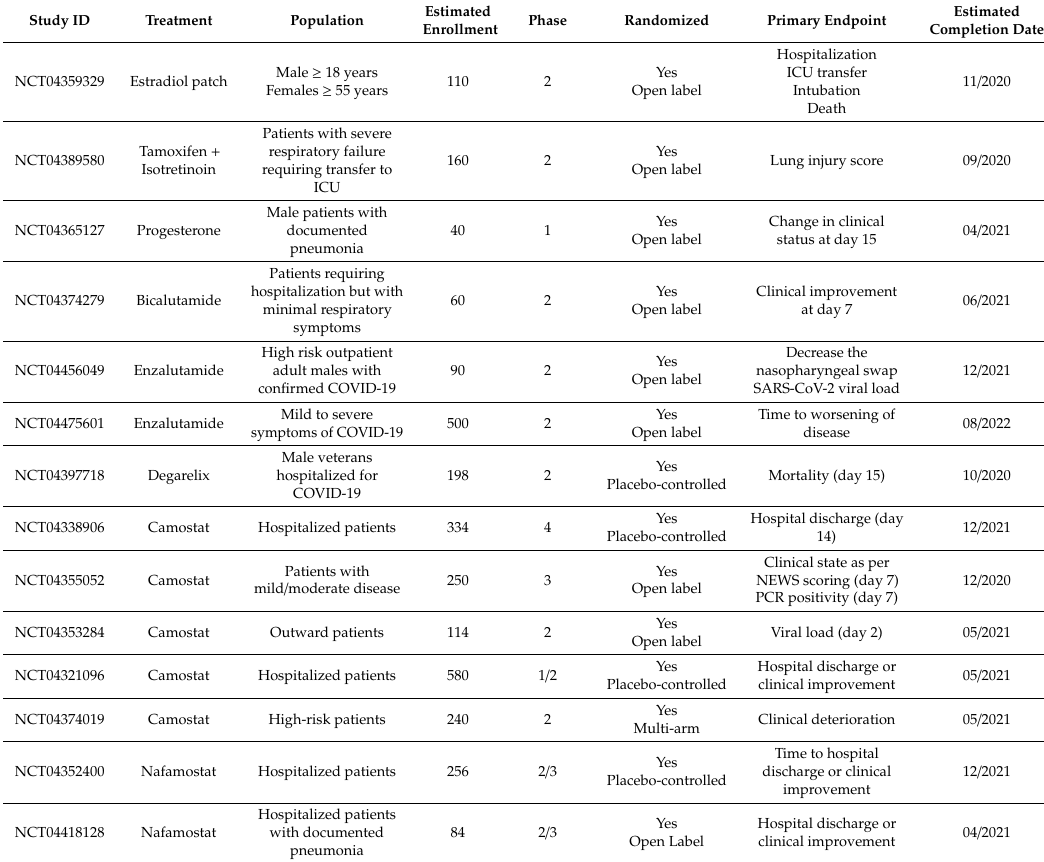
Table 1. On-going studies of hormone therapies and TMPRSS2 inhibitors in coronavirus disease 2019 (COVID-19)